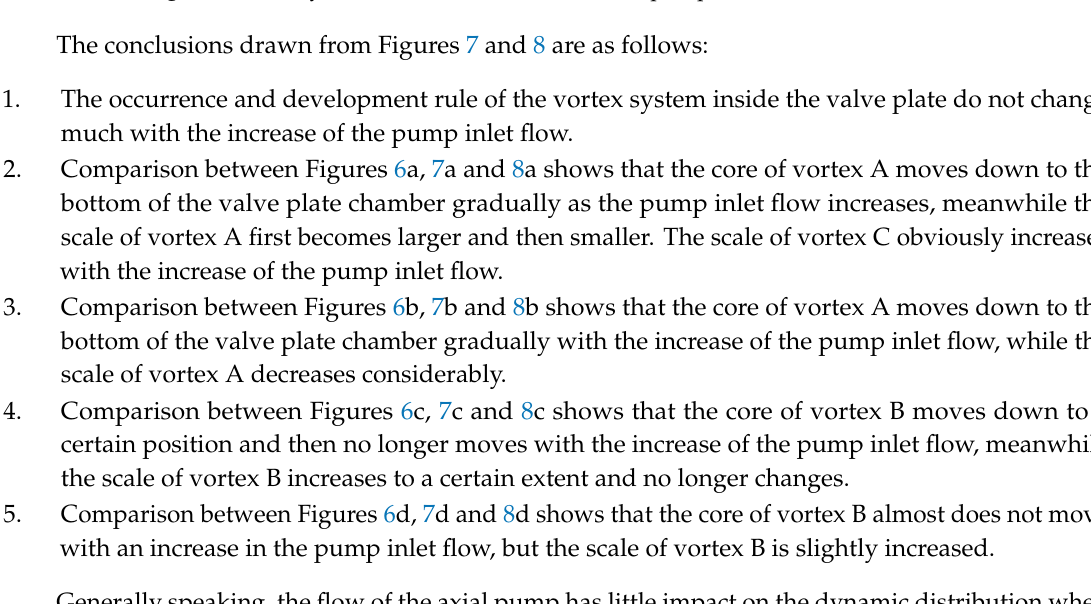
Figure 8. Velocity contours and streamlines with a pump inlet flow of 950 mL/min.